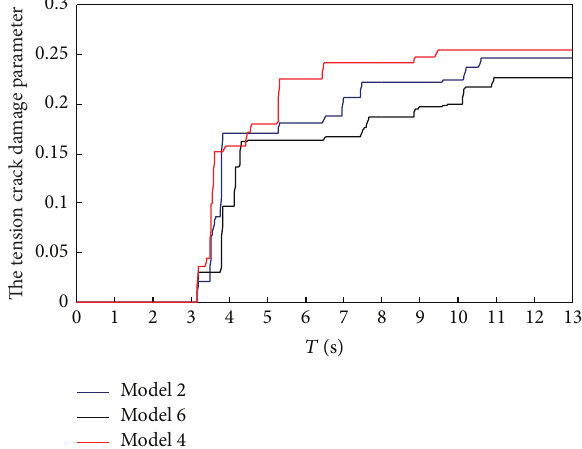
Figure 25: The tension crack damage parameter of pier between windows under Wolong ground